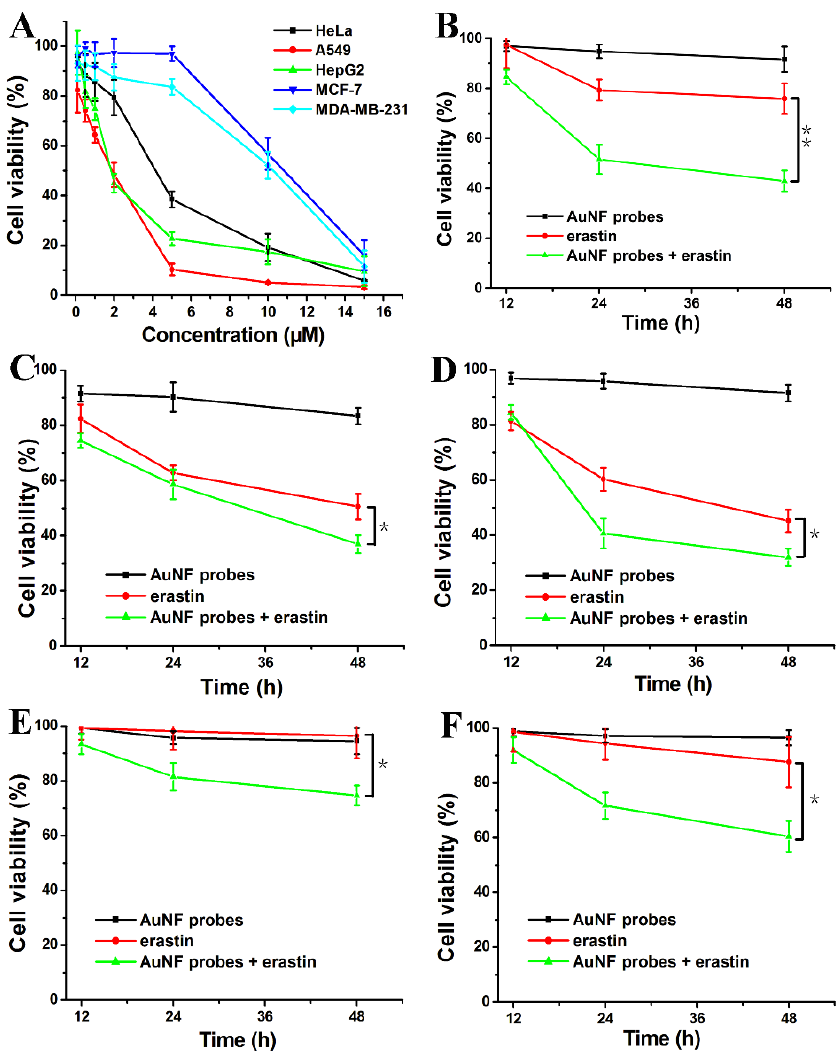
Figure 6. ( A ) Cell viabilities of different cancer cell lines when treated with different concentrations of erastin (0.1, 0.5, 1.0, 2.0, 5.0, 10.0, and 15.0 µM) for 48 h. Cell viability of HeLa ( B ), A549 ( C ), HepG2 ( D ), MCF-7 ( E ), and MDA-MB-231 cells ( F ) when treated with AuNF probes (1.5 nM), erastin (2.0 µM), and AuNF probes (1.5 nM) + erastin (2.0 µM) for different times (12, 24, and 48 h). p < 0.05 (*); p < 0.01